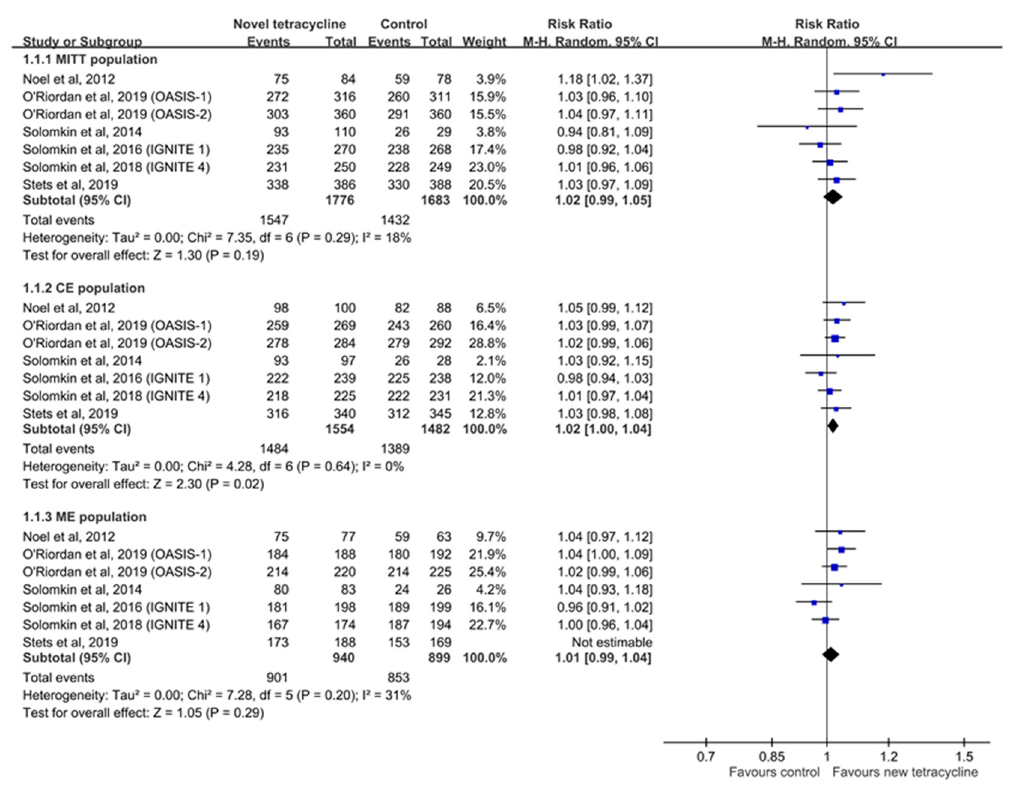
Figure 3. Forest plot of clinical response rate at the test of cure visit among modified intent-to-treat (MITT) population, clinically evaluable (CE) population, and microbiological evaluable (ME) population. Novel tetracyclines exhibited similar clinical efficacy to that of comparators for treating infections of both gram-positive (RR: 1.01, 95% CI: 0.97–1.05, I 2 = 0%) and gram-negative (RR: 0.99, 95% CI: 0.94–1.05, I 2 = 0%) aerobes. There was no exception for Staphylococcus aureus (RR: 1.03, 95% CI: 0.98–1.08, I 2 = 0%) as well as MRSA (RR: 1.04, 95% CI: 0.98–1.11, I 2 = 0%).